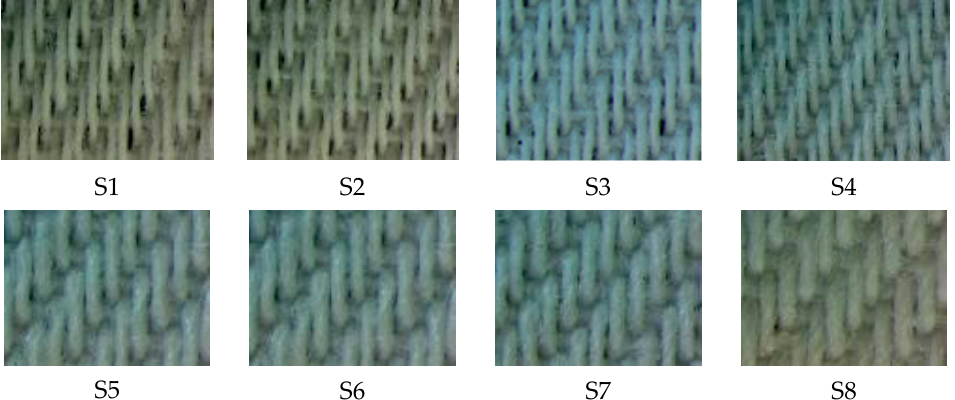
Figure 5. Magnification of images of eight woven fabric samples with different weft densities. The dark area indicates holes, otherwise the images consist of yarn. The magnification sample S5–S8 is displayed bigger than S1–S4.